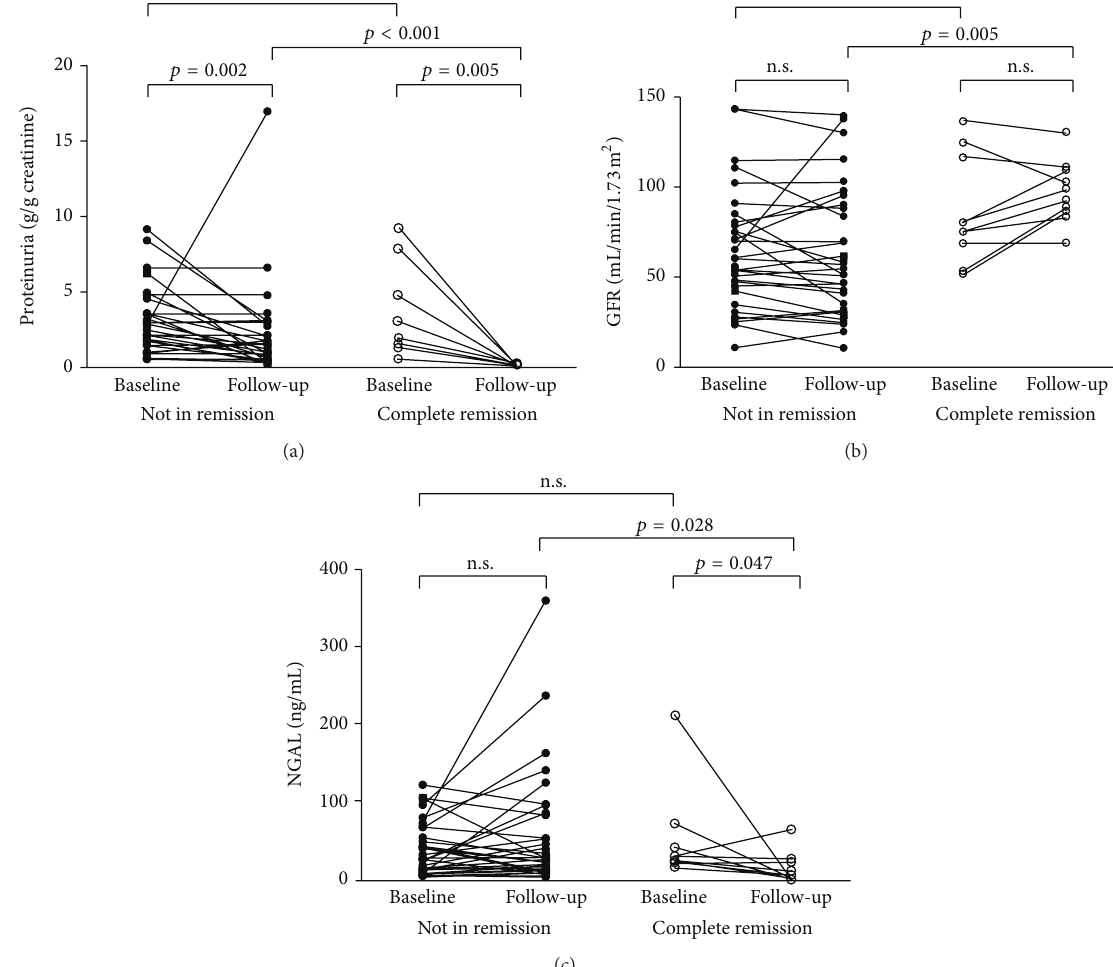
𝑝 = 0.63 ). Reduction in NGAL was greater in